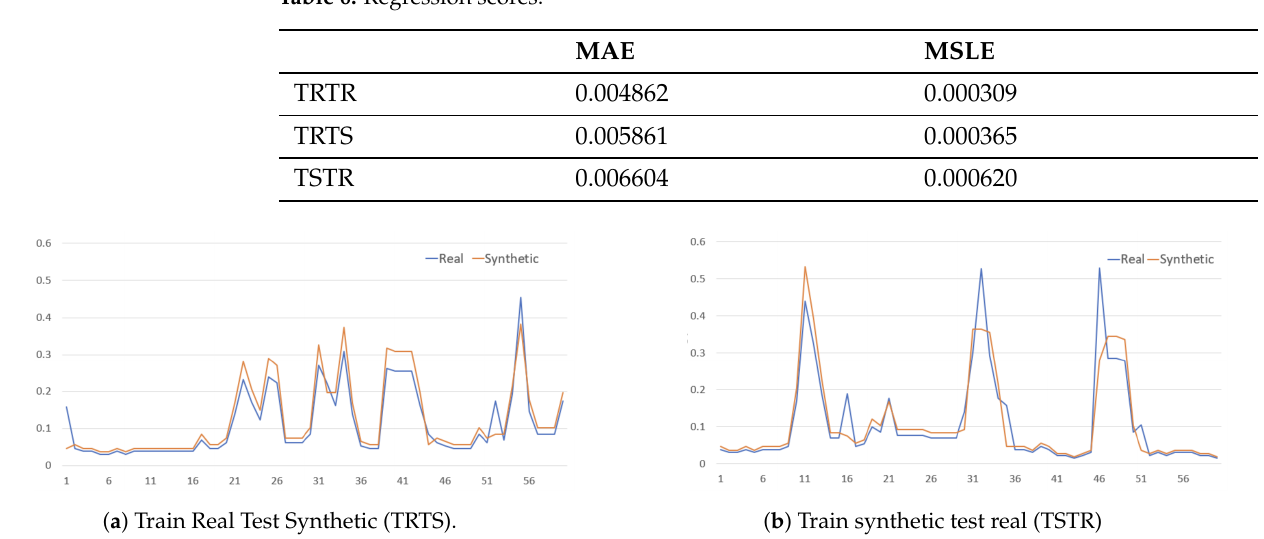
Table 6. Regression scores.